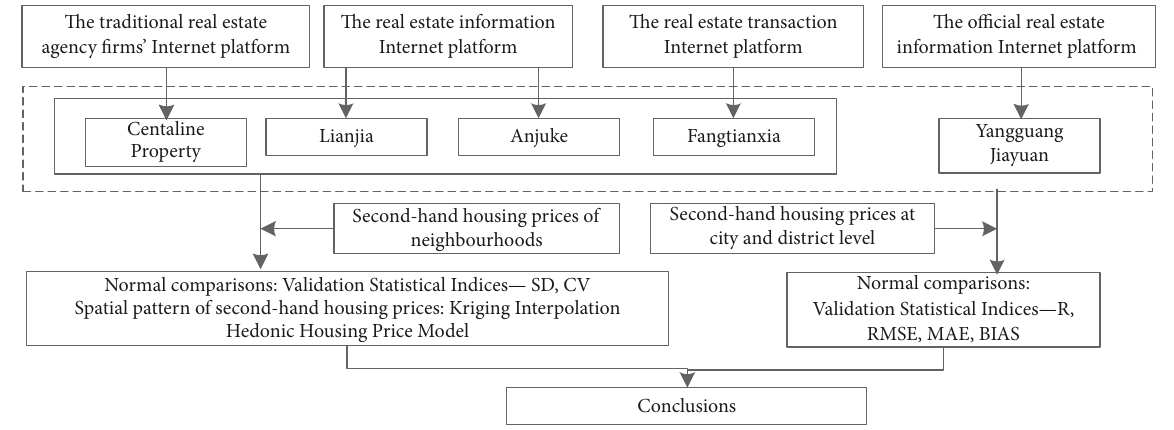
Figure 1: Flowchart of the housing price evaluation process.